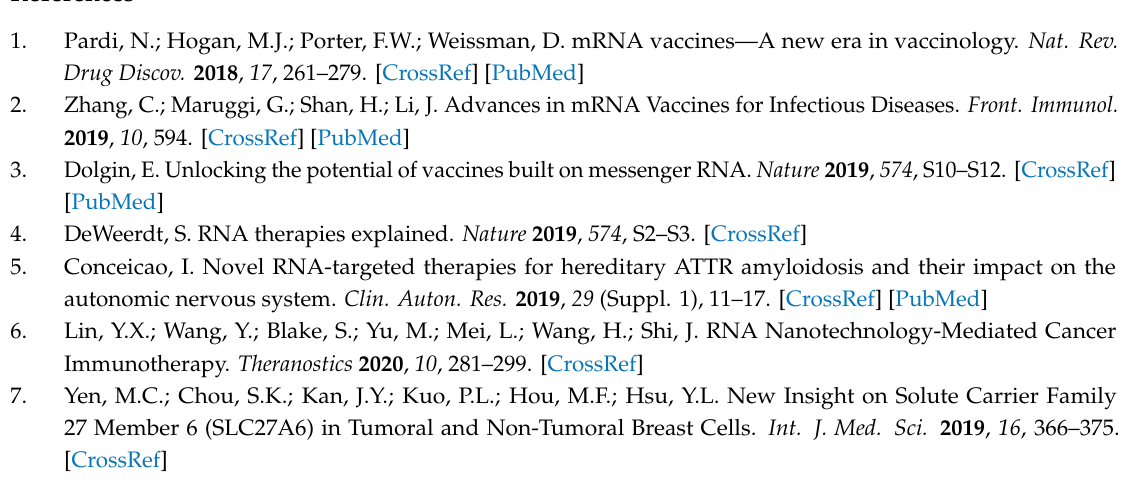
Table S4. The list of non-coding RNA genes in splenic neutrophils with significant